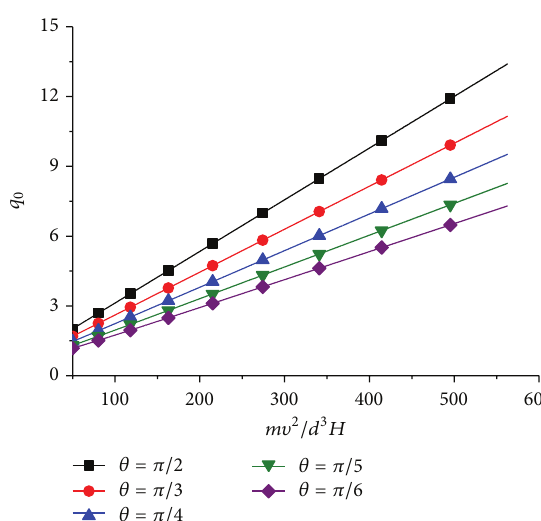
Figure 15: The dimensionless resistance on projectile.